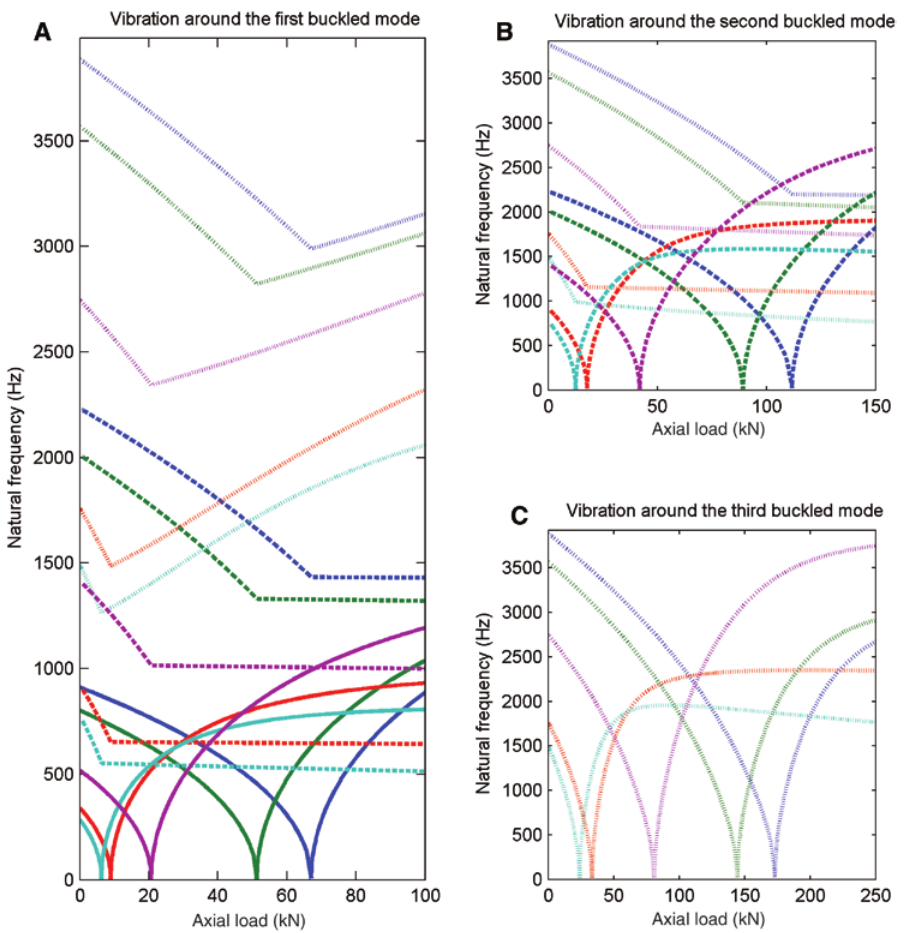
Figure 9 Variation of the natural frequency around the first three buckled configurations with the applied axial load for different laminates of a CC